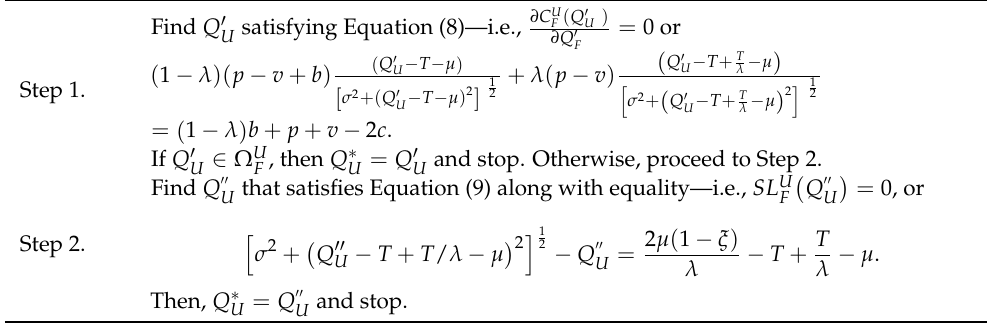
Algorithm 2. Determining the optimal order quantity only when the average and standard deviation are available.